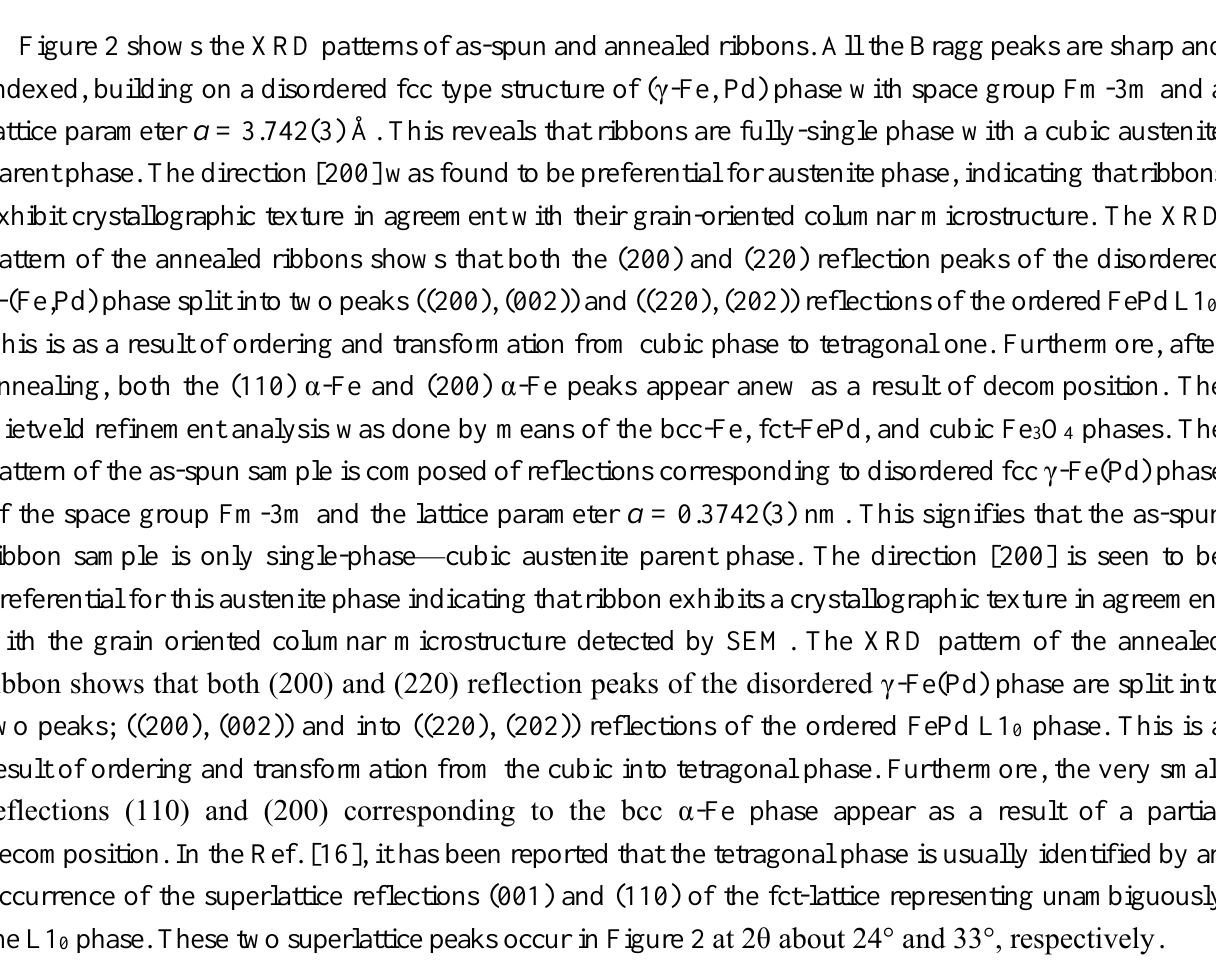
Figure 2. XRD patterns of as-spun and annealed Fe 68.45 Pd 28.21 Co 1.66 Ni 1.66